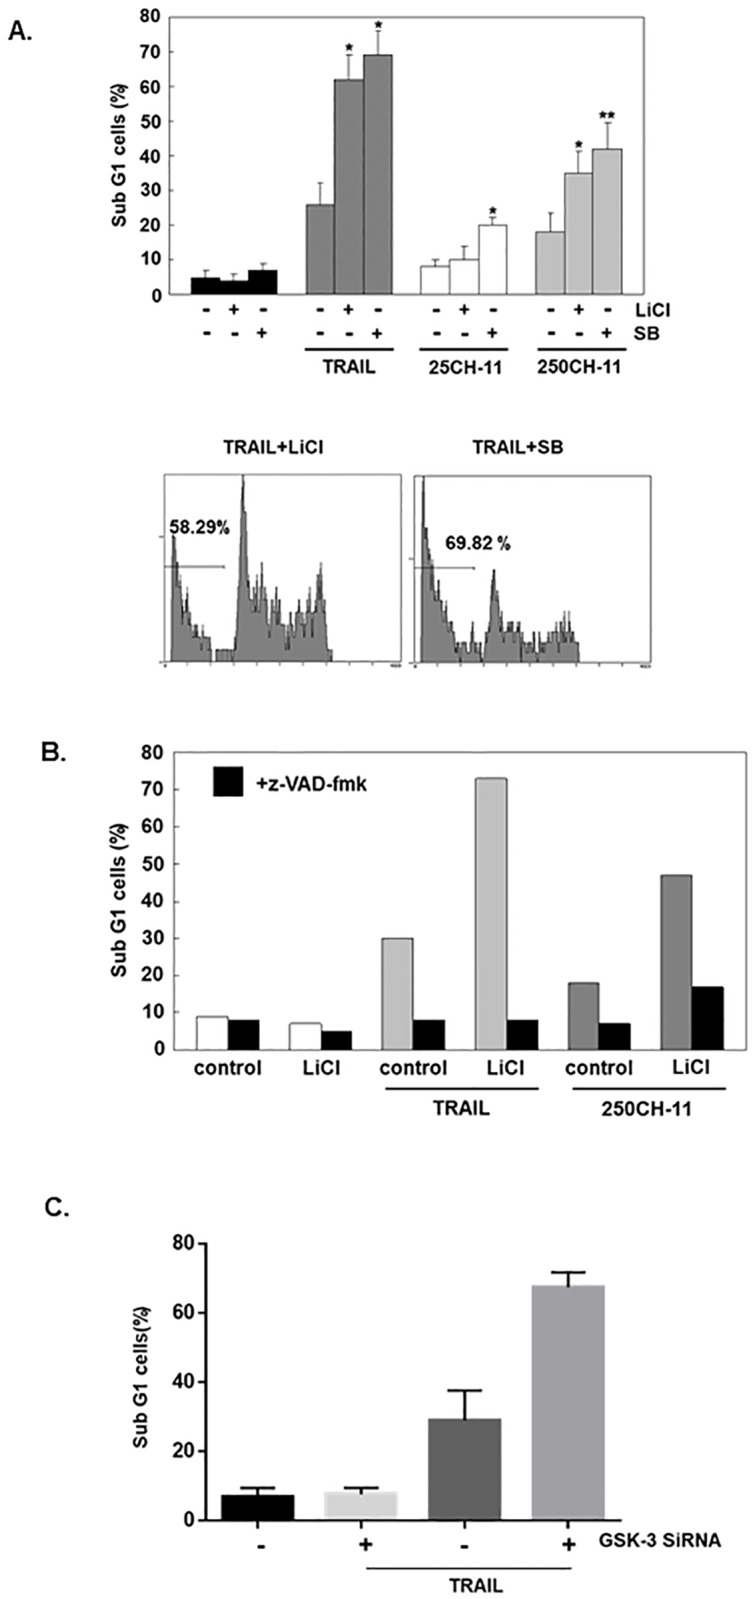
Effects of GSK-3 inhibitor on apoptosis induced by agonistic anti-CD95 and TRAIL in gastric adenocarcinoma cell line AGS.(A) AGS cells were treated with or without TRAIL (25 ng/mL), CH-11 (agonistic anti-CD95 antibodies) (25 ng/mL or 250 ng/mL), LiCl (20 mM) or SB (25 μM). Flow cytometry analysis was used to analyze sub-G1 cell populations. The results are shown as mean ± the standard error (SE) of four independent experiments. (B) AGS cells were incubated with TRAIL (25 ng/mL), agonistic anti-CD95 antibodies (250 ng/mL), LiCl (20 mM) or z-VAD-fmk for 24 hours (20 μM). Then sub-G1 cells were analyzed using flow cytometry. The result was the mean of three independent experiments. The statistical significance was determined by comparison with cells treated with DR (death receptor) agonist only (*, p <0.05; **, p < 0.01). (C) siRNA against GSK3 increases the TRAIL cytolytic killing of AGS cells (n = 5).